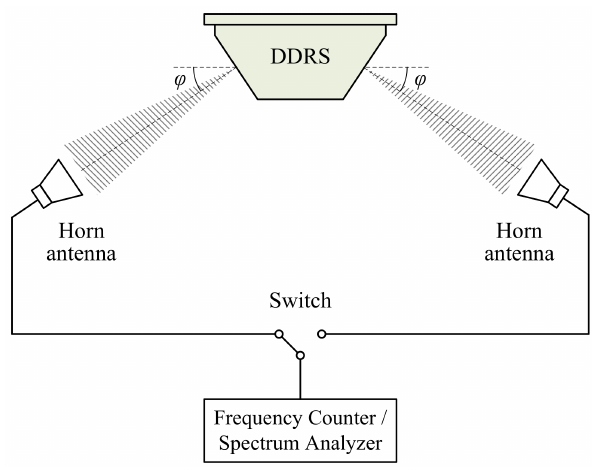
Figure 7. Block diagram of emitted frequency measurement system for the